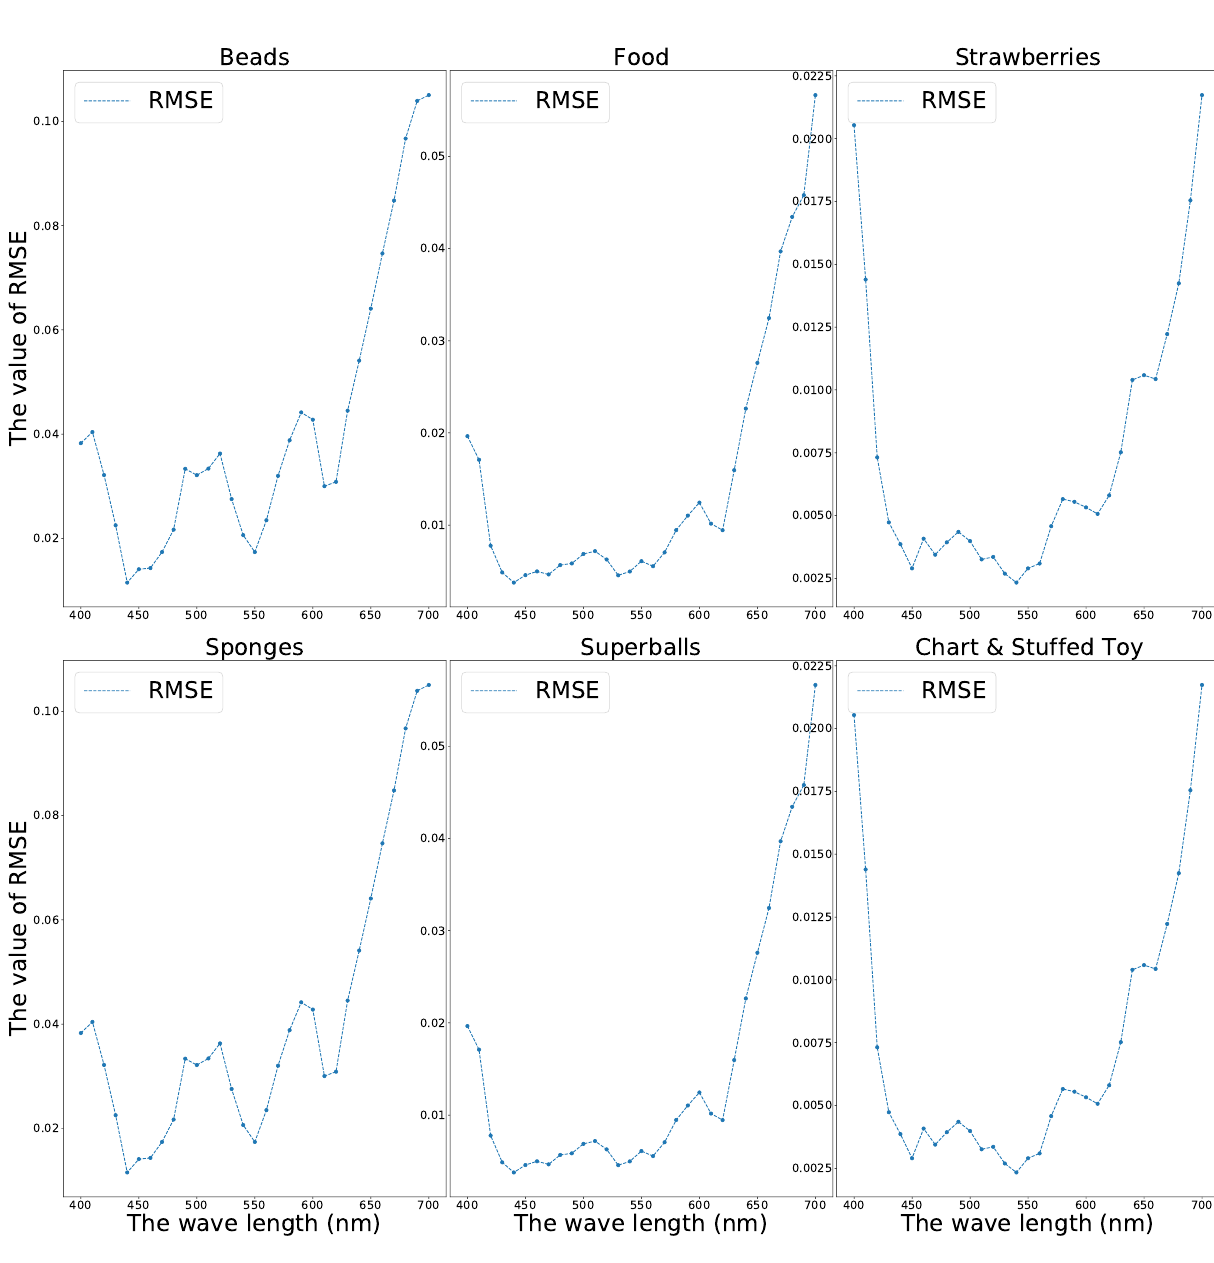
Figure 10. The RMSE wavelines of multispectral image restoration with the CAVE